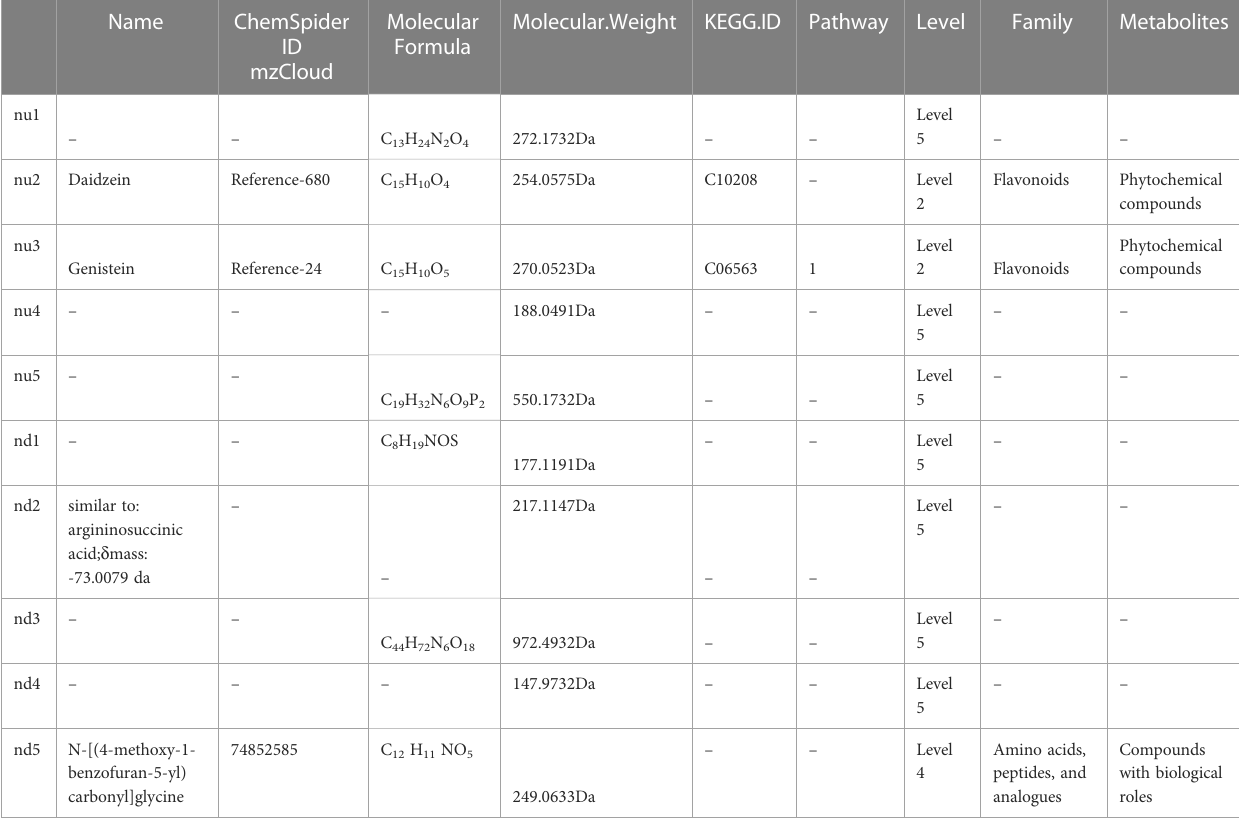
TABLE 5 Detailed information about top 5 (pu1-pu5) up-regulated and top 5 (pd1-pd5) down-regulated differential metabolites in Negative ion